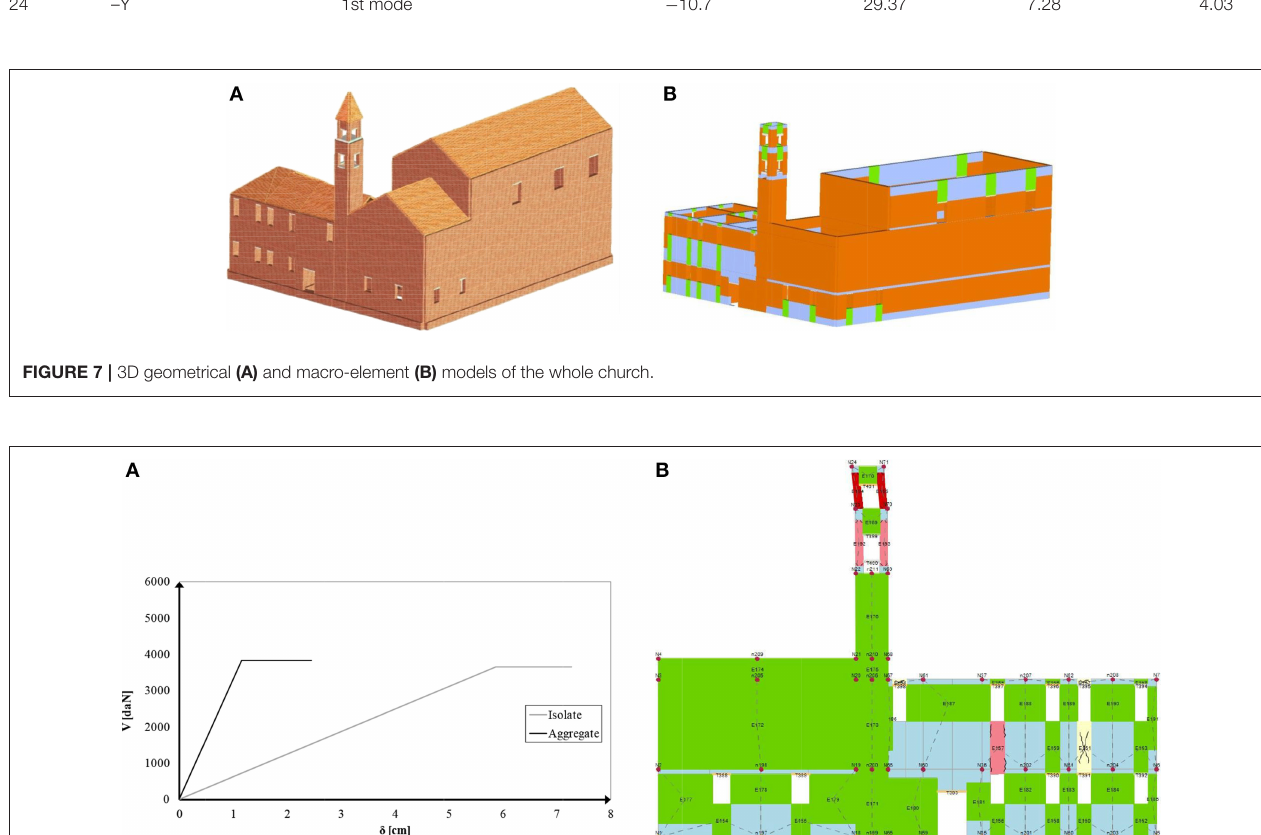
FIGURE 8 | Comparison between bi-linear pushover curves in direction y (analysis n. 24) of the bell tower in the two structural configurations considered (A) and deformed shape of the church at the end of this pushing phase (B)